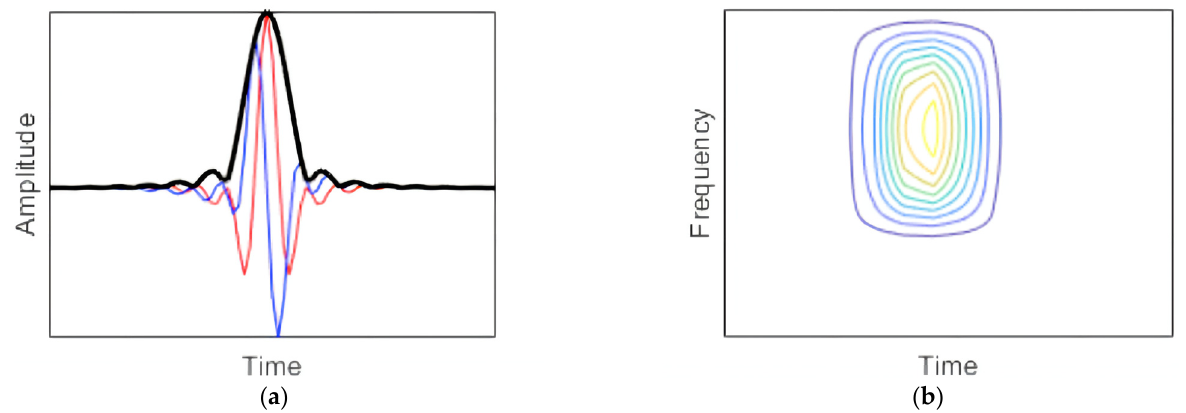
Figure 1. Definition of bump wavelet: ( a ) History of bump wavelet; ( b ) Time–frequency spectra of bump wavelet.